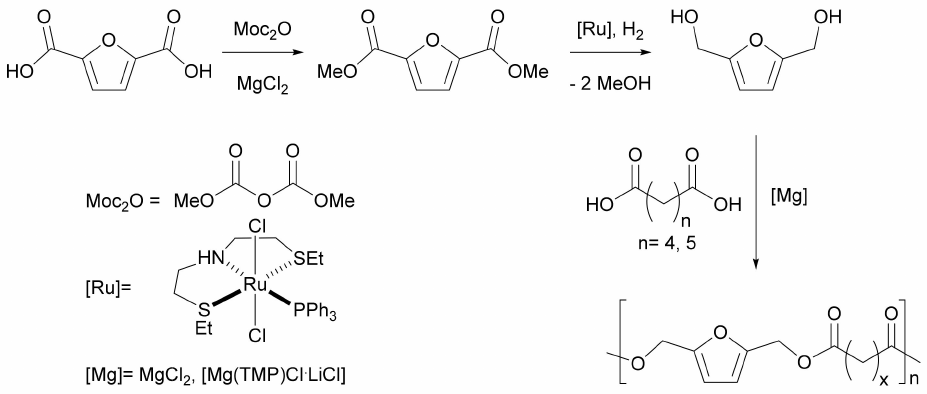
Figure 6. Glass transition temperature of 2,5-bis(hydroxymethyl)furan-based polyesters of increasing diacid chain length. Reprinted with permission from reference [41]. Copyright 2014 American Chemical